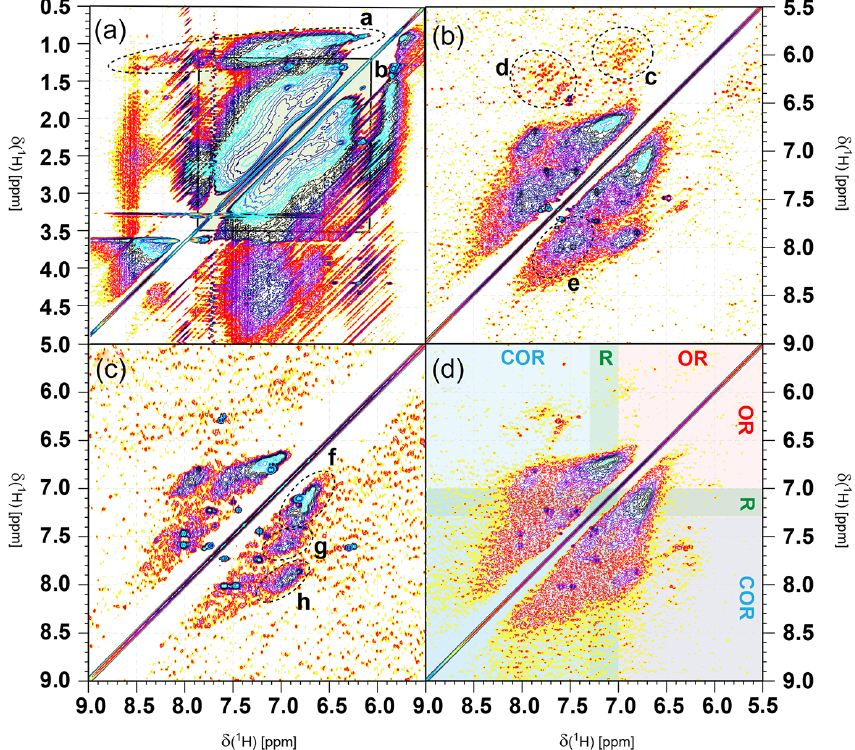
Figure 3. TOCSY NMR spectra (800MHz, CD 3 OD) of wetland SPE-DOM. (a) TOCSY cross-peaks between aliphatic protons (X–C sp3 H – C sp3 H –X; X: C, O) for samples FCE-S. (b–d) TOCSY cross-peaks between unsaturated protons (X–C sp2 H –C sp2 H –X; X: C, O) for samples FCE-S, PAN-L and OKA-S respectively. Section (a): H 3 C–C n –X cross-peaks, with n = 1 ( δ H >3) and n >1 ( δ H <3); where X is any het- eroatom, likely oxygen; section (b): –C–C H –C H –C n –X–, intra-aliphatic cross-peaks; section (c): α , β -unsaturated and conjugated double bonds: H C olefin = C olefin H –(C = O)–X; section (d): polarized α , β -unsaturated double bonds: H C olefin = C olefin H –(C = O)–X; section (e): congested fjord region in polycyclic aromatics; section (f): aromatics H C aromatic –C aromatic H with ortho- or/and para-oxygenated substituents (classic aromatic substitution of DOM); section (g): condensed and strongly electron-withdrawing aromatics H C aromatic –C aromatic H (mul- tiply carboxylated, N-heterocycles); section (h): (more extended) polycyclic aromatics, polycarboxylated aromatics, N-heterocycles. (d) Sections of chemical shift for substituted aromatics as proposed by the SPARIA model (substitution patterns in aromatic rings by increment analysis): COR, electron-withdrawing substituents; R, electroneutral substituents; OR, electron-donating substituents (Perdue et al.,